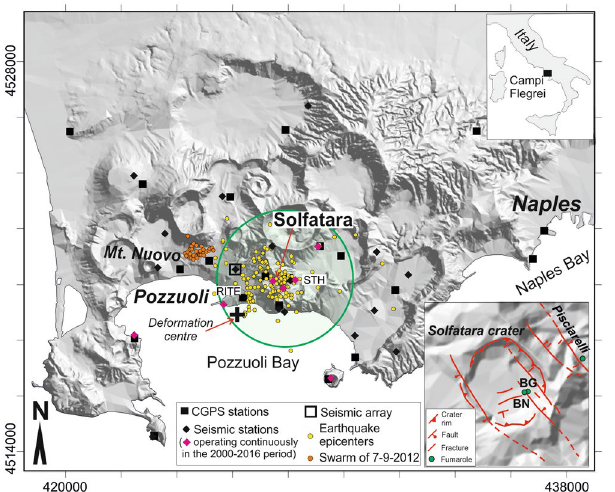
Figure 1. Campi Flegrei caldera and the monitoring system of the Osservatorio Vesuviano-INGV. The map was obtained using the open-access digital elevation model of Italy, TINITALY/01 54 . The seismic and geodetic networks comprise 23 seismic stations, one small aperture seismic array, and 20 continuous GPS stations (CGPS). The map shows the location of the fumaroles that are systematically sampled (BG and BN in Solfatara crater and Pisciarelli, right bottom inset). The green circle is the horizontal section of the computational domain used in the TOUGH2 model. The yellow and orange circles are the post-2000 earthquake epicentres of the best located events 9 . The earthquakes generally occurred in the area of the computational domain of the fluid-dynamic model with the exception of a swarm of events happened on September 2012 (orange circles). Figure generated with Surfer 10 by Golden Software (http://www.goldensoftware.com/products/surfer) and CorelDRAW X5